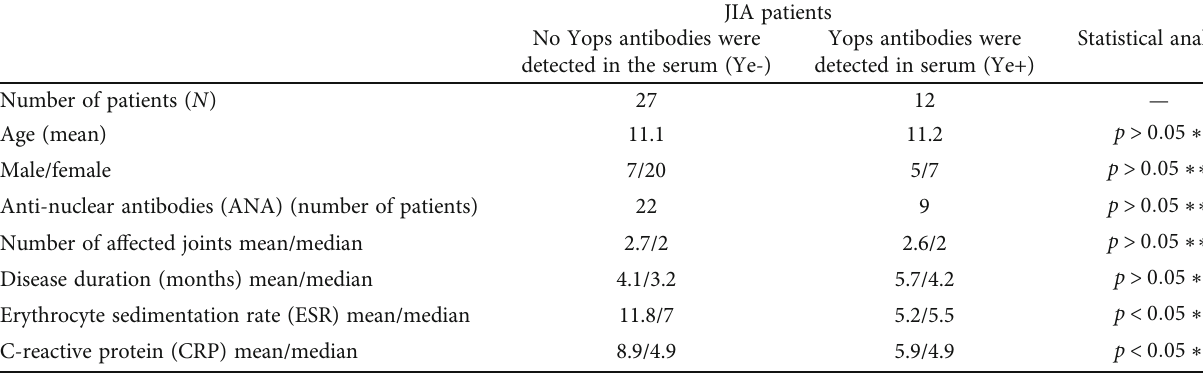
Table 1: The comparison of clinical data for JIA patients positive and negative for Yersinia Yops antibodies.